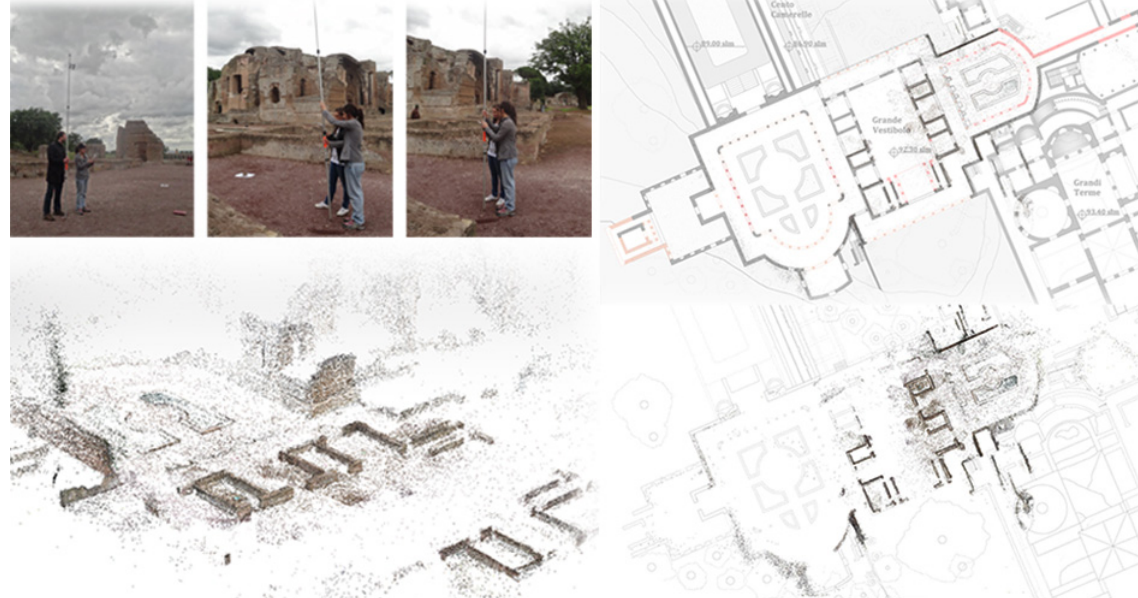
Figure 5. Photogrammetric